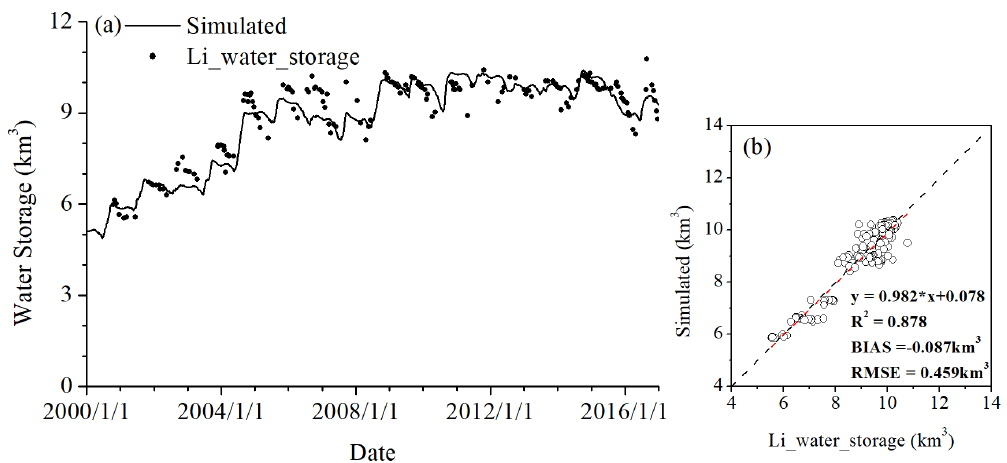
Figure 9. Comparison of the daily simulated lake water storage (LWS) and the LWS derived from